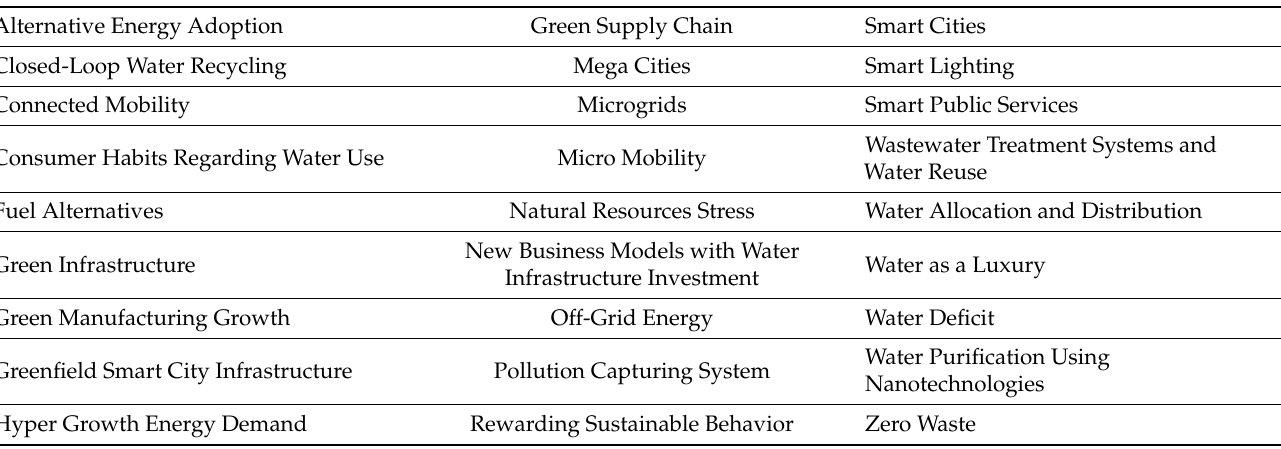
Table 1. Water, energy, and future of the cities ´ megatrends.